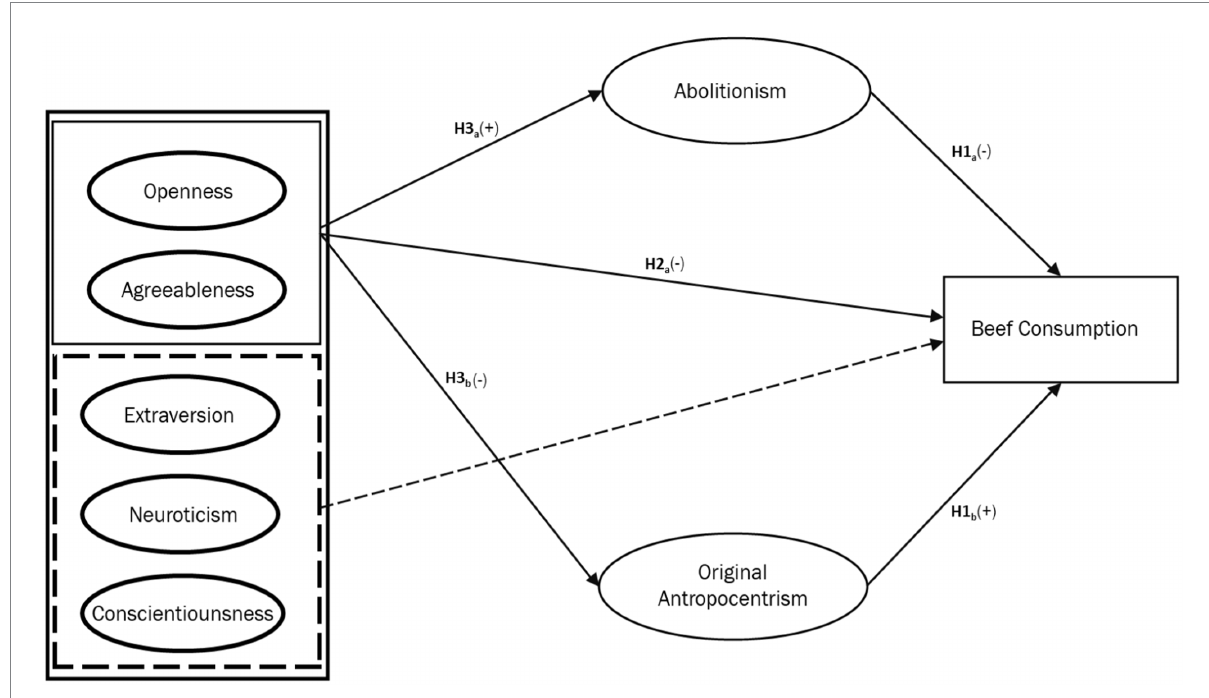
FIGURE 1 Conceptual model depicting the hypothesized relationships between the big five personality traits. Abolitionist ethical intuition, and frequency of beef